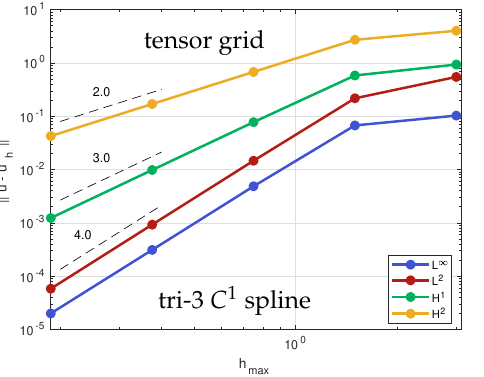
Figure 8. Optimal convergence of tri-3 C 1 spline for the biharmonic equation on the tensor grid. To accommodate irregular box-complexes, discontinuous Galerkin elements with polygonal boundaries have been applied, see, e.g., [65–67]. Ref. [68] states optimal nu- merical convergence for quad meshes but provides no data for hexahedral meshes. Their approach matches boundary data via a penalty function. Below, we will compare the results of tri-3 C 1 splines to Catmull-Clark solids on unstructured box-complexes. The authors of an efficient implementation of Catmull-Clark solids on unstructured box-complexes [40] were not aware of publications that cover Catmull-Clark solid convergence for fourth-order equations. (Recall that the estimates of [18,19] rely on higher than C 1 smoothness for fourth-order problems and, therefore, do not